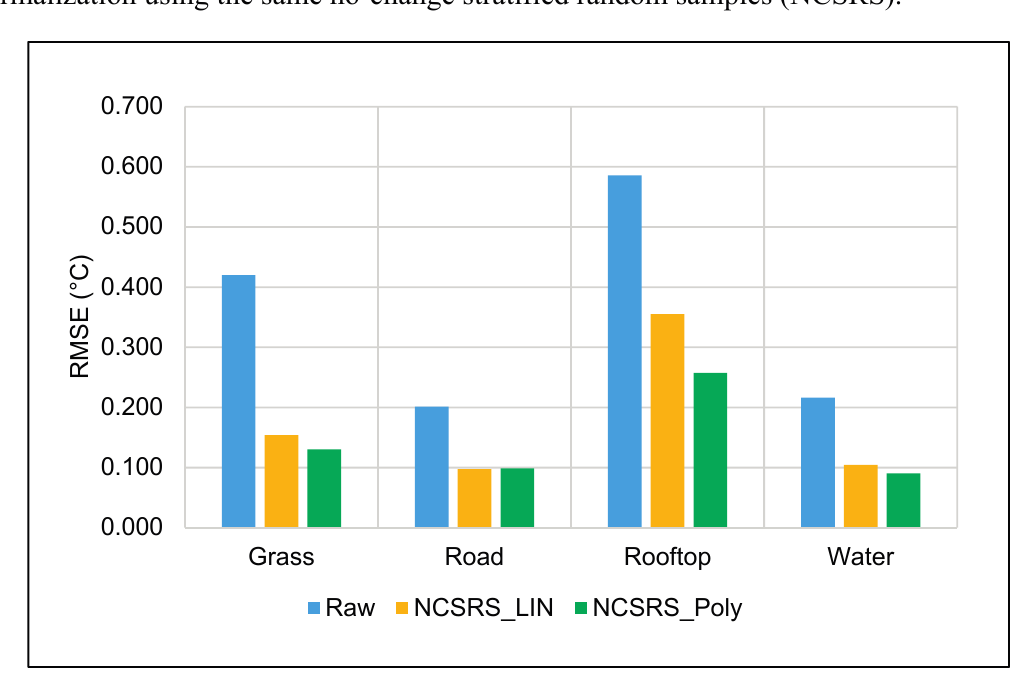
Figure 8. A comparison of linear (LIN) and polynomial (Poly) regression-based radiometric normalization using the same no-change stratified random samples